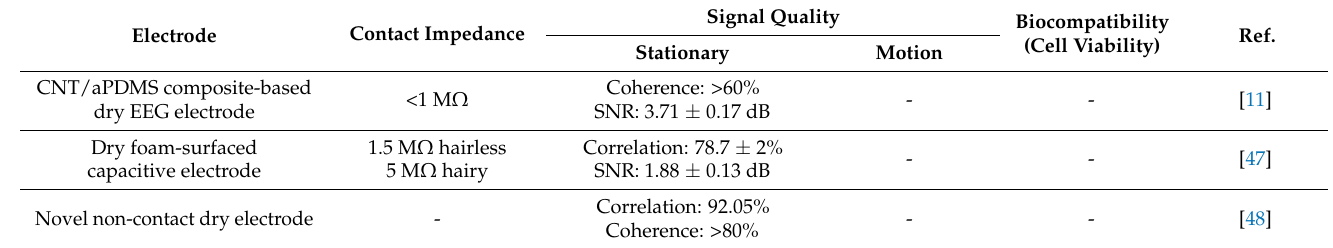
Table A3. Comparison of performance of the selected dry non-contact EEG electrode.